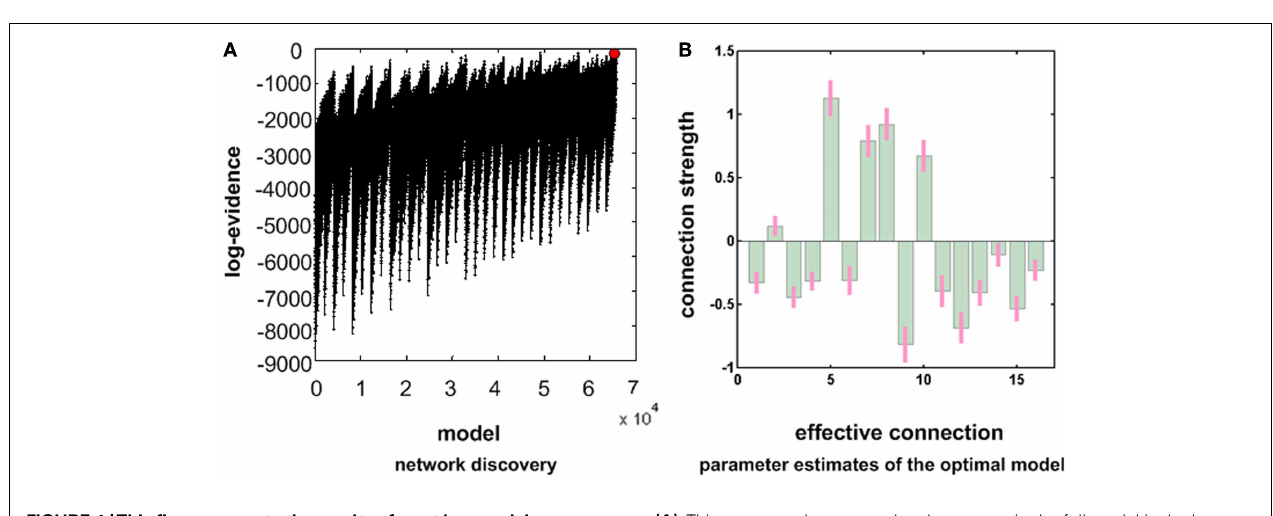
FIGURE 4 |This figure presents the results of post hoc model optimization or network discovery. Having inverted a full model with full extrinsic connectivity, we then assessed the log model evidence for all reduced models (models with one or more missing connections).The model with the highest evidence was the full model – as can be seen in